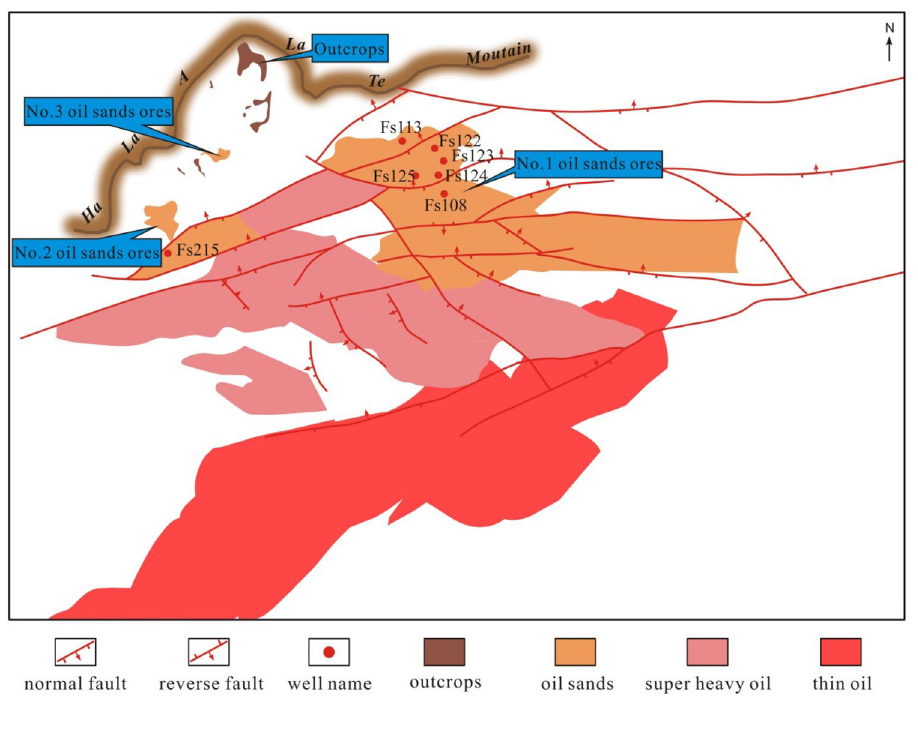
Fig. 2 Metallogenic model of oil